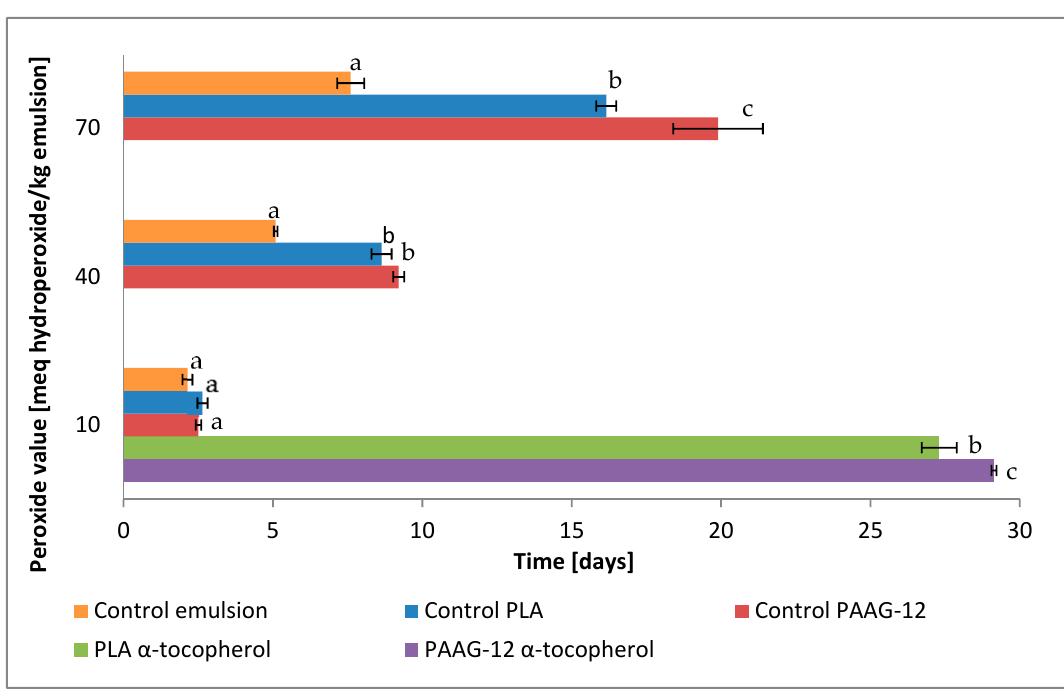
Figure 5. Time for samples to reach di ff erent peroxide values (graph). Samples with di ff erent letters Figure 5 . Time for samples to reach different peroxide values (graph). Samples with different letters denote significant di ff erences ( p < denote significant differences ( p < 0.01) .